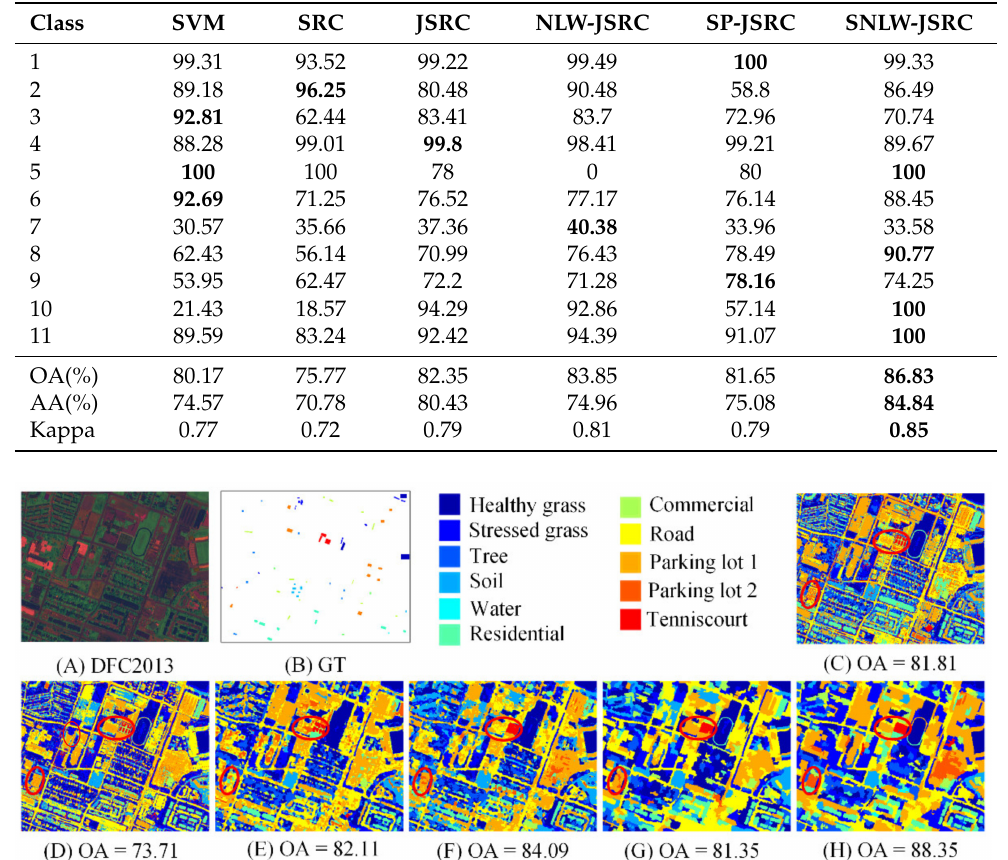
Table 8. Accuracy of DFC2013 classification results (the best result in each row is highlighted in bold).